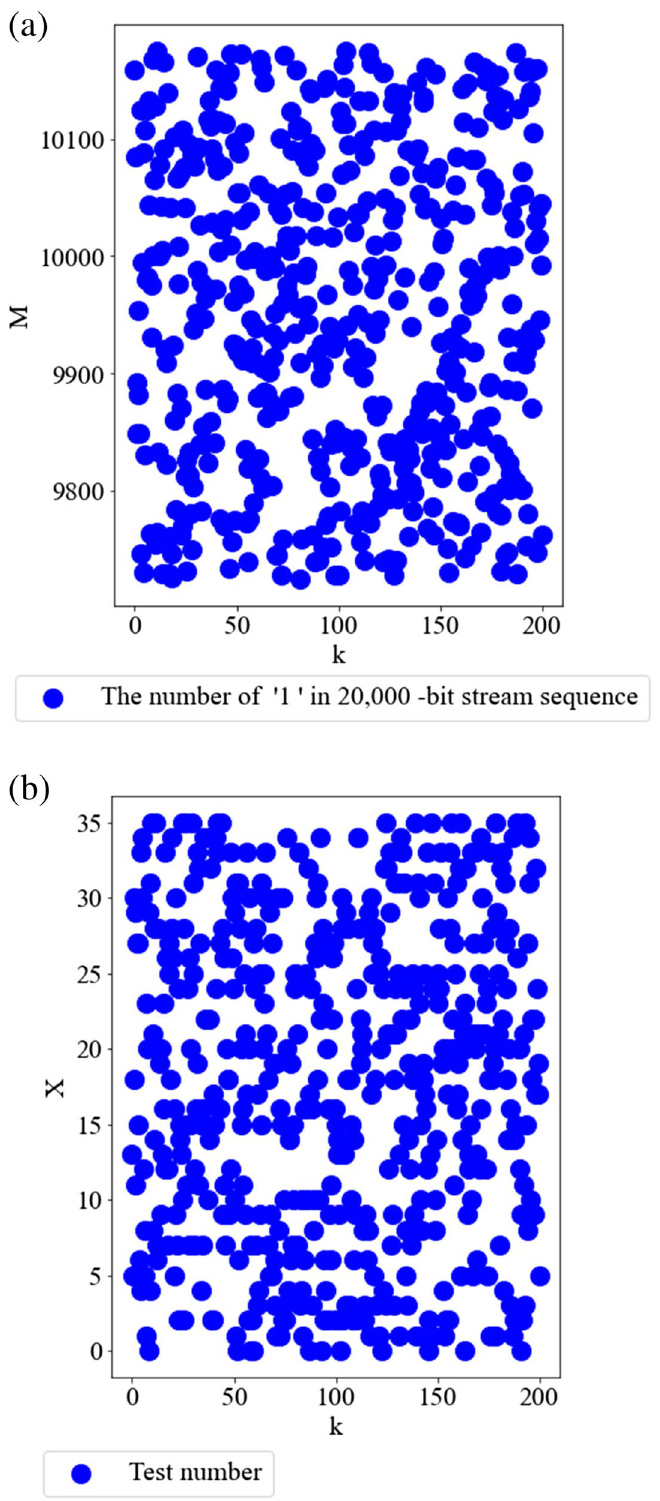
Fig. 3 The result of a the Monobit test and b the Poker